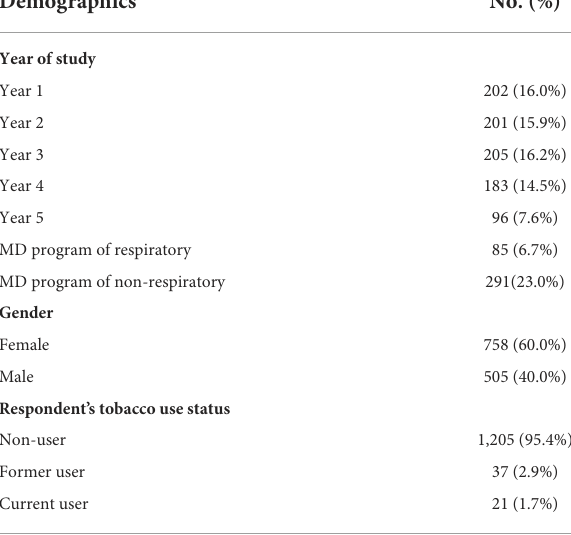
TABLE 1 Students’ year of study, their gender and tobacco use status ( n = 1,263).